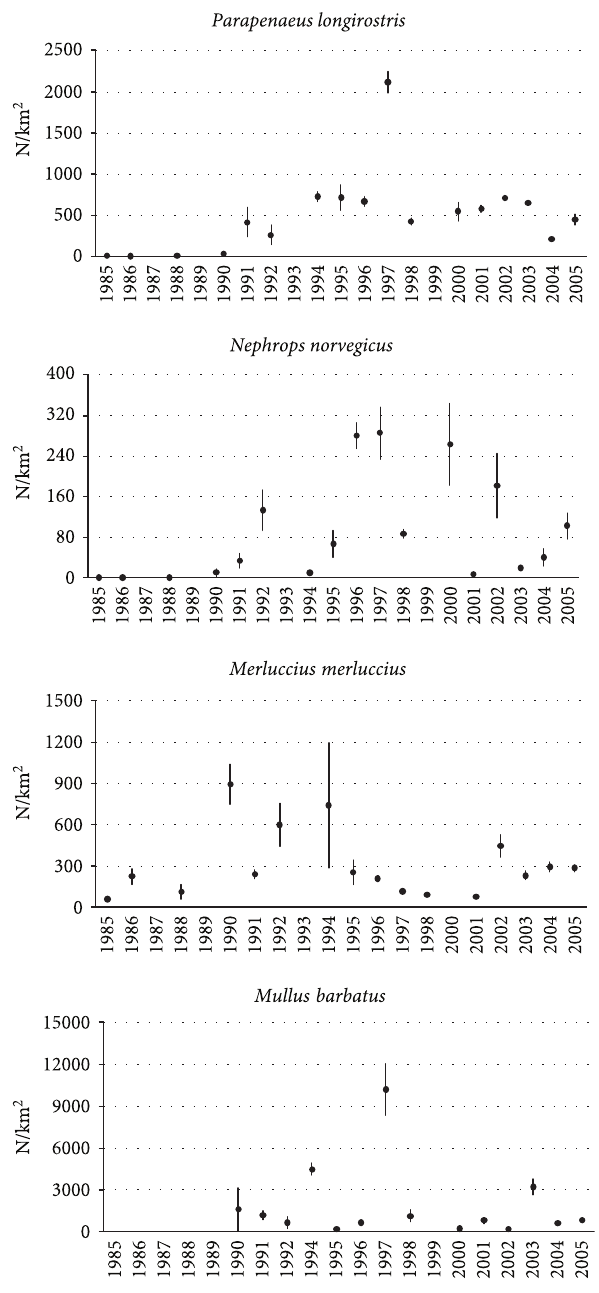
Figure 6: Recruitment indices (N/km 2 ) with standard deviation of demersal species caught from 1985 to 2005 in the north-western Ionian